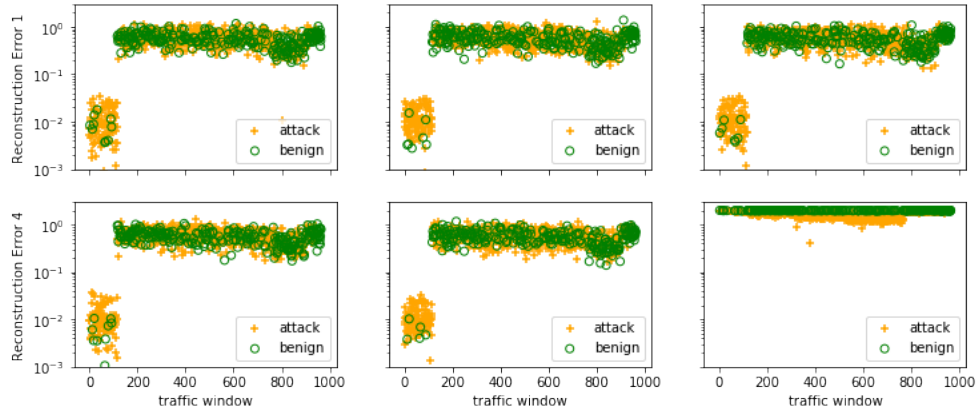
Figure 5. The features used to train the random forest model in Stage 2. The lower right graph shows the entropies of windows with all benign or with one or more attack flows. The other five are the reconstruction errors produced by the LSTM model in Stage 1. The LSTM model was trained prior to this with all benign traffic. The data are plotted on a log